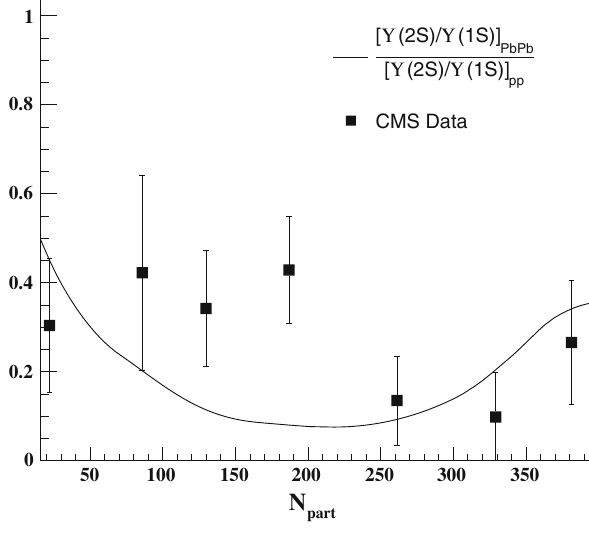
Fig. 25 Variation of survival probability (S) of [ ϒ( 2 S )/ϒ( 1 S ) ] / [ ϒ( 2 S )/ϒ( 1 S ) ] √ PbPb pp with respect to N part at s NN = 2 . 76 TeV. Experimental Data is taken center of mass energy from Refs.